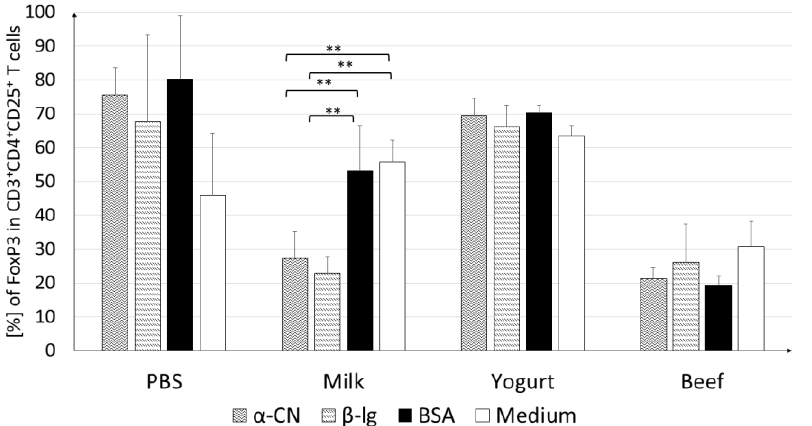
Figure 6. FoxP3 + cells among CD4 + CD25 + splenocytes. Cells were stimulated with 100 µ g / mL of α -CN, β -lg, or BSA and incubated at 37 ◦ C for 120 h. Data are the mean ± SD. ** p < 0.01, one-way ANOVA with Tukey post-hoc tests.